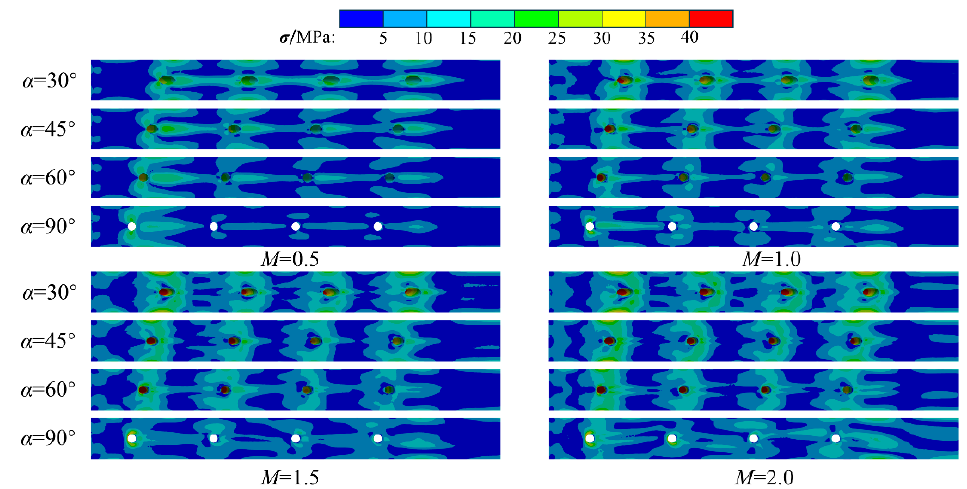
Figure 14. Contours of thermal stress on external wall of film plate for cases with different values of α at each M .